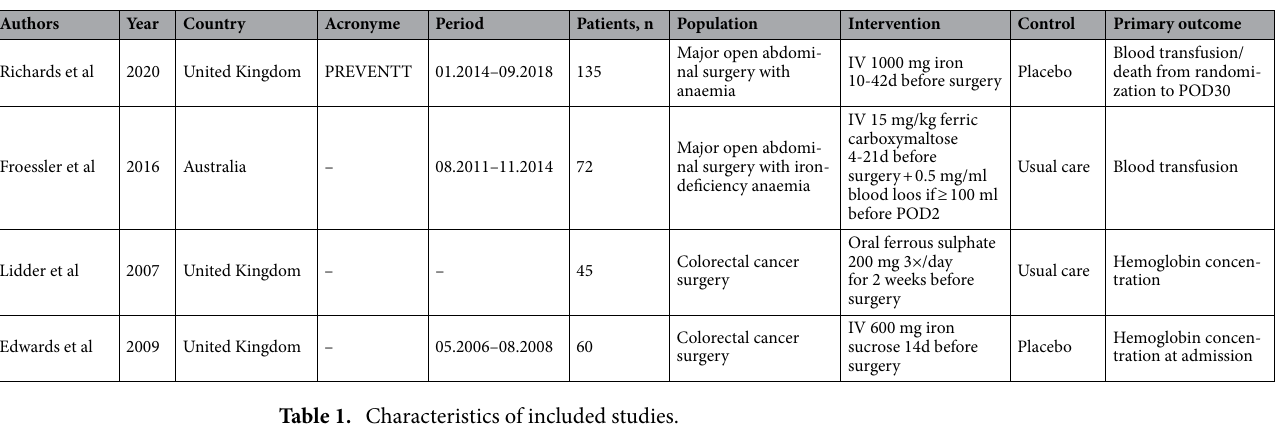
Table 1. Characteristics of included